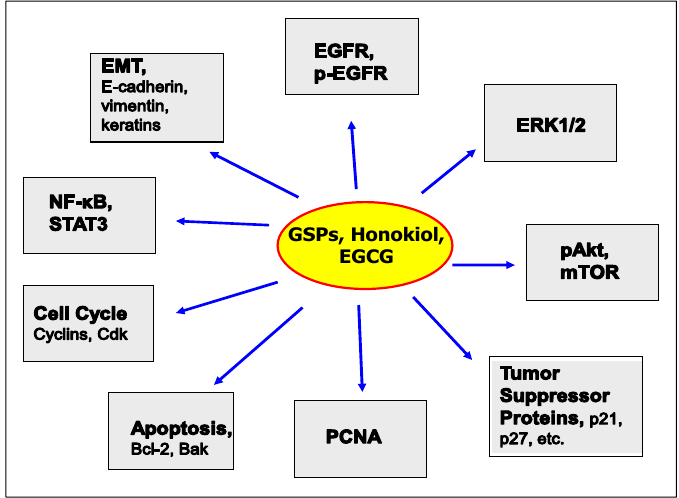
Figure 2. Molecular targets of phytochemicals (GSPs, honokiol and green tea polyphenols) in the prevention or treatment of HNSCC. Studies have shown that the major molecular targets of these phytochemicals on HNSCCs are EGFR, EMT, cell cycle regulators, apoptotic proteins and PCNA, etc. as shown.